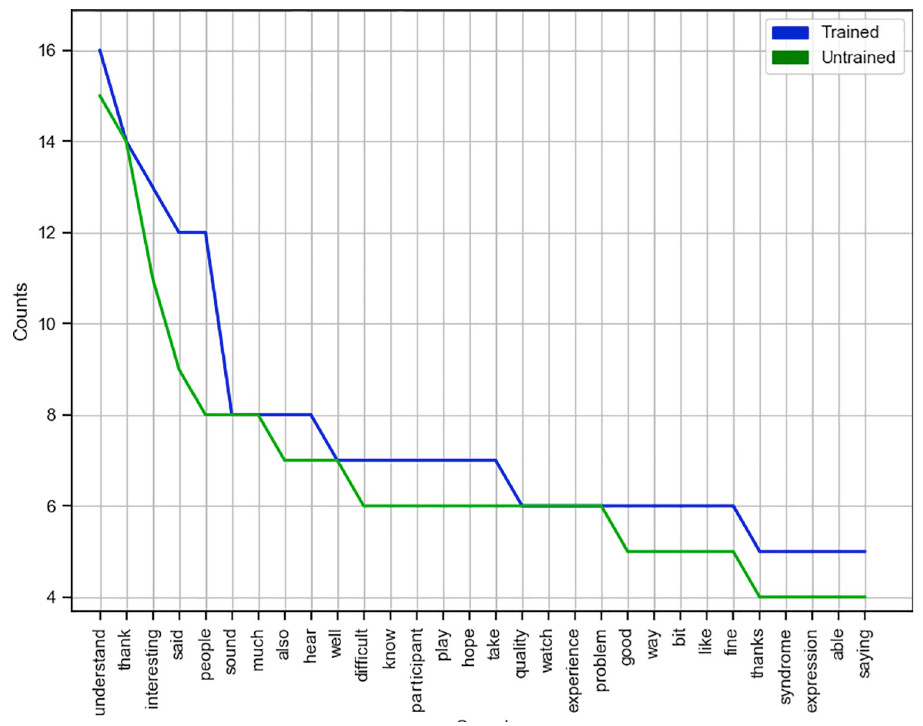
Fig 6. Themes. Frequency Distribution of Common Themes based on Participants’